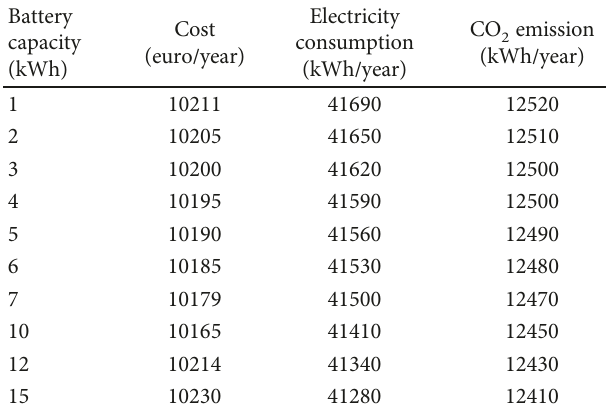
Table 5: Advanced EH system performance for several BESS sizes.